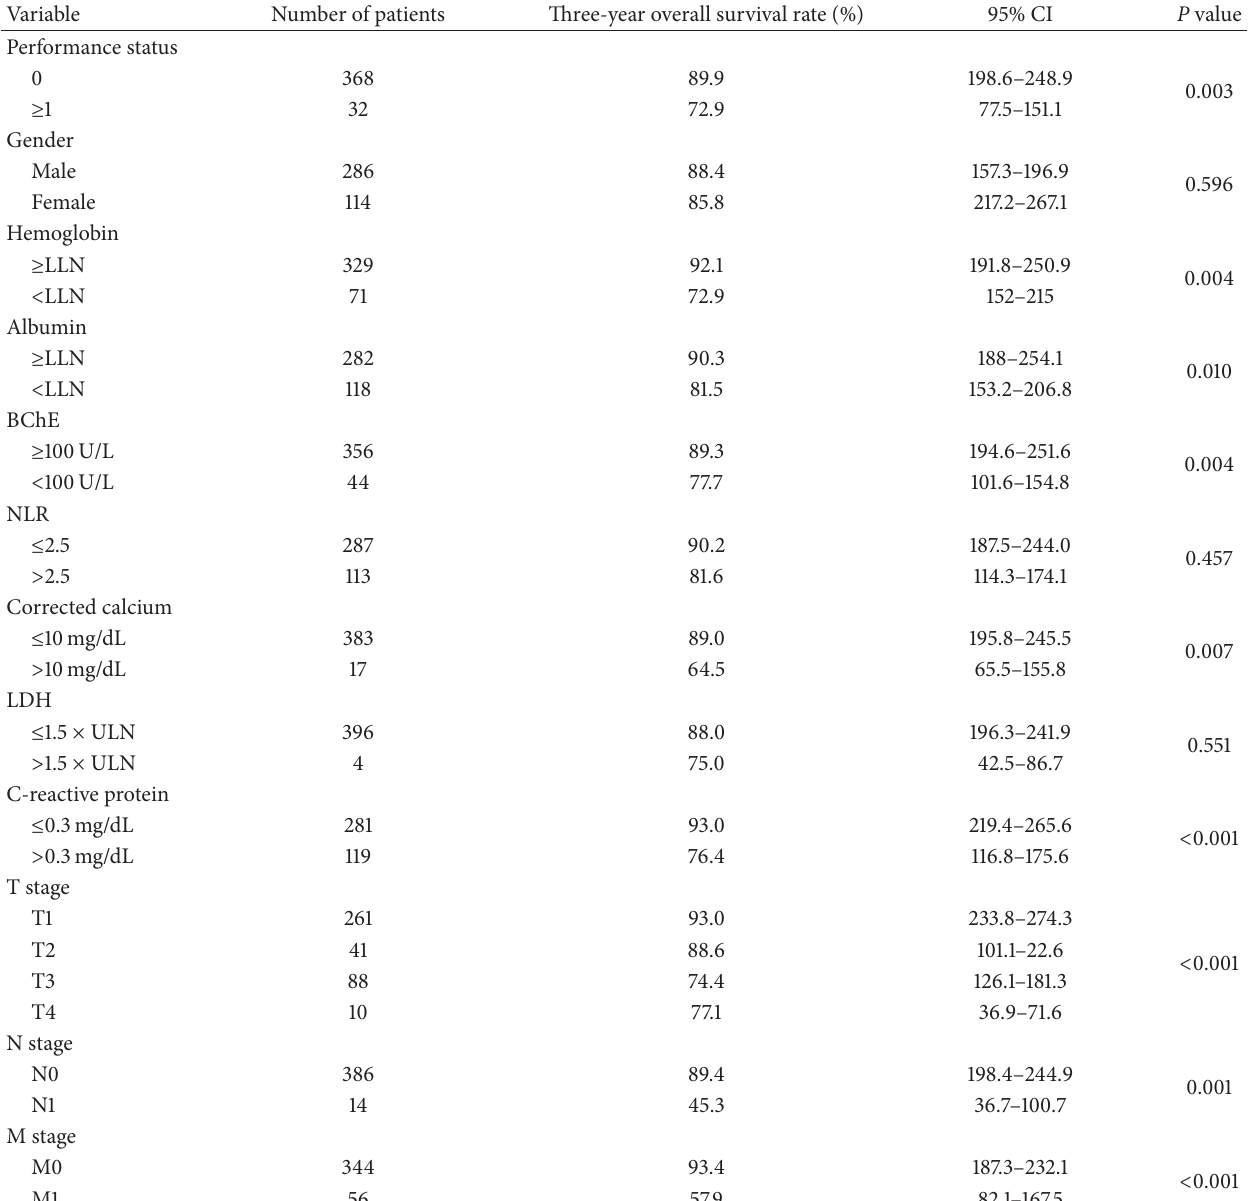
Table 2: Relationship between clinical factors and overall survival in clear cell renal cell